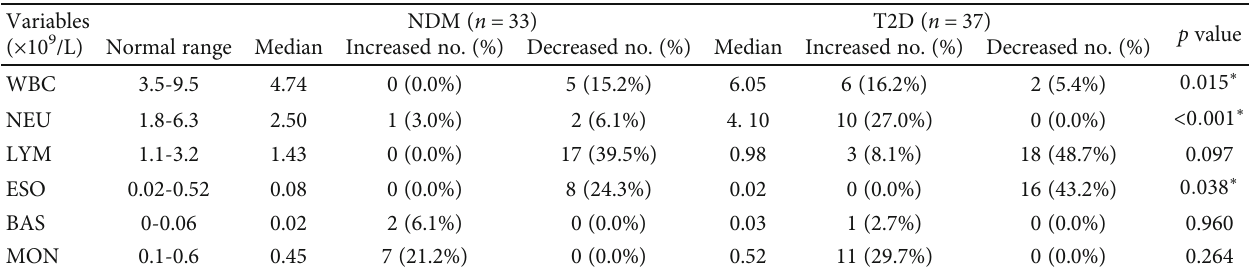
Table 2: Laboratory fi ndings of white cell subpopulations in patients with diabetes or not infected with